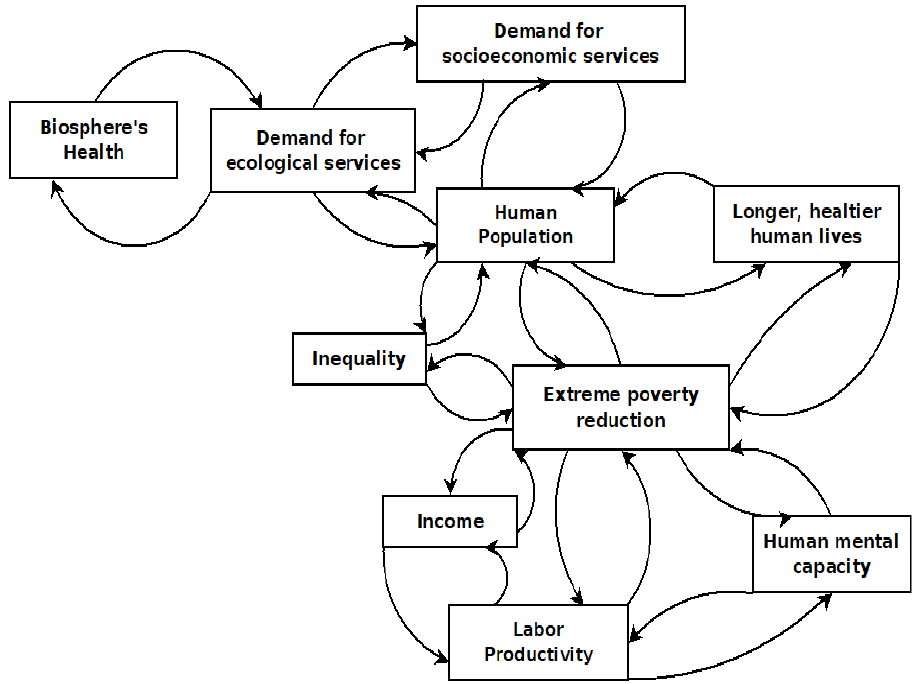
Figure 2. Nonlinear dynamics of extreme poverty reduction.